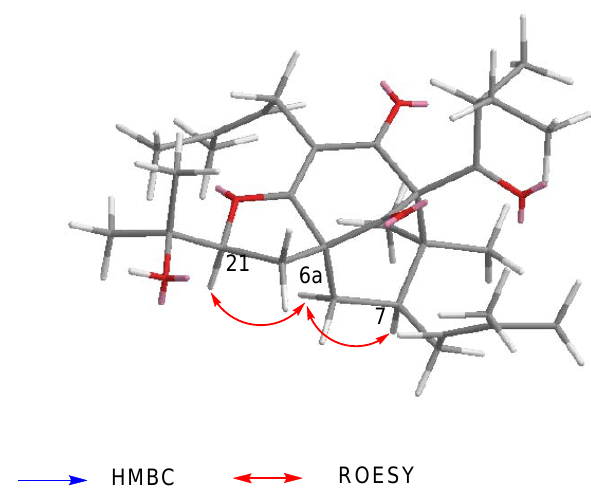
Figure 4. Key 2D NMR correlations of hyperacmosin S ( 2 ).